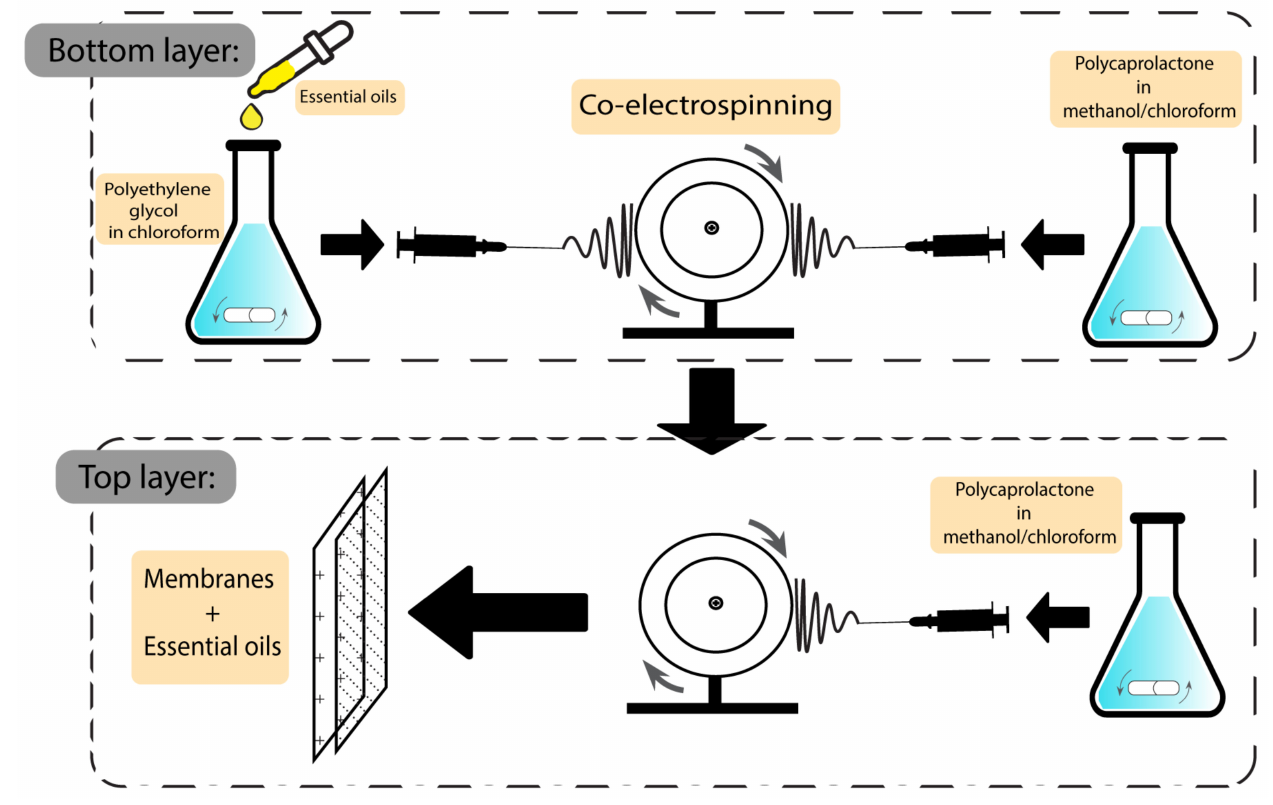
Figure 8. Preparation scheme of essential oil-based polycaprolactone